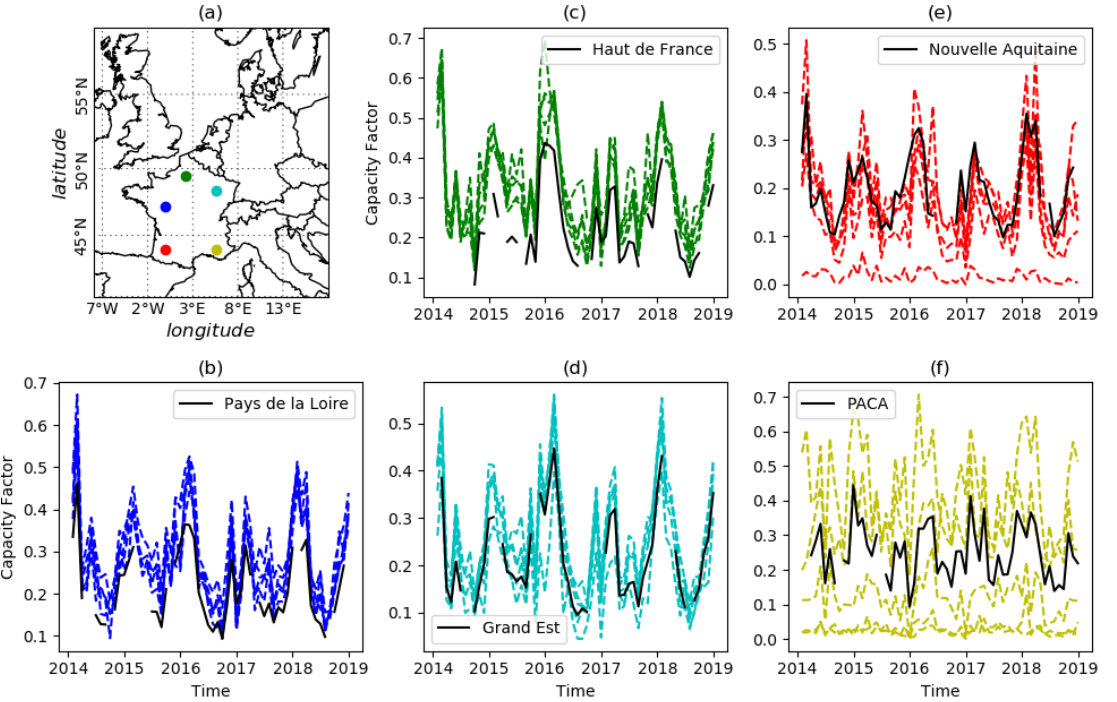
Figure A4. Time series of observed (black) and modelled (dashed) monthly capacity factor in five French regions: Pays de la Loire ( b ), Haut de France ( c ), Grand Est ( d ), Nouvelle Aquitaine ( e ) and PACA ( f ). Subfigure ( a ) shows the location of the regions on the